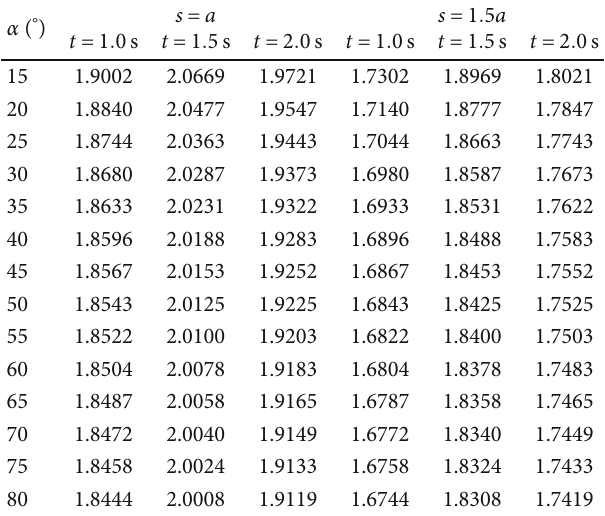
Table 4: Calculation results of f angles ( α